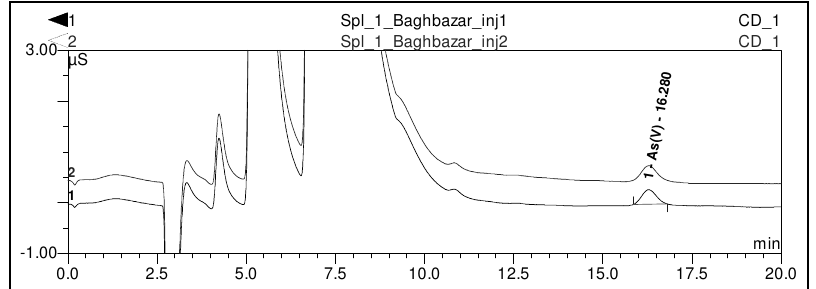
Figure 5. Electrochemical (amperometry) detection of sample_1_Baghbazar for arsenite content (duplicate injections).